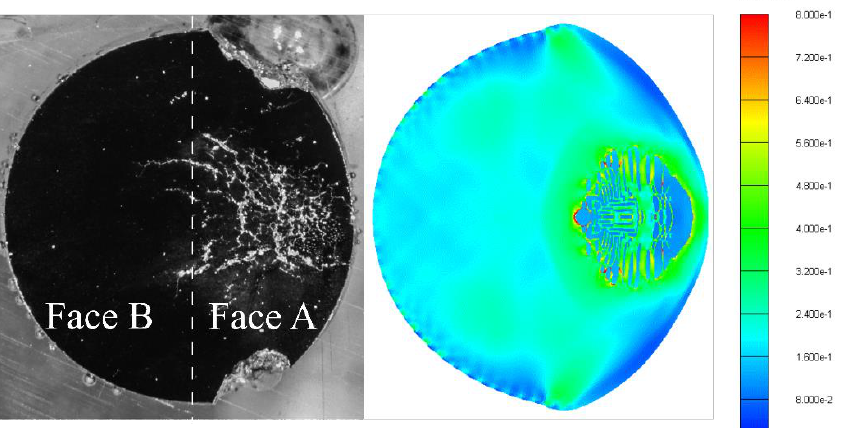
Fig. 5 Comparison of a sectioned ball bearing from a 5.13 g detonation (left) and the effective plastic strain contour from an equivalent simulation at 2.5 μs after detonation (right).